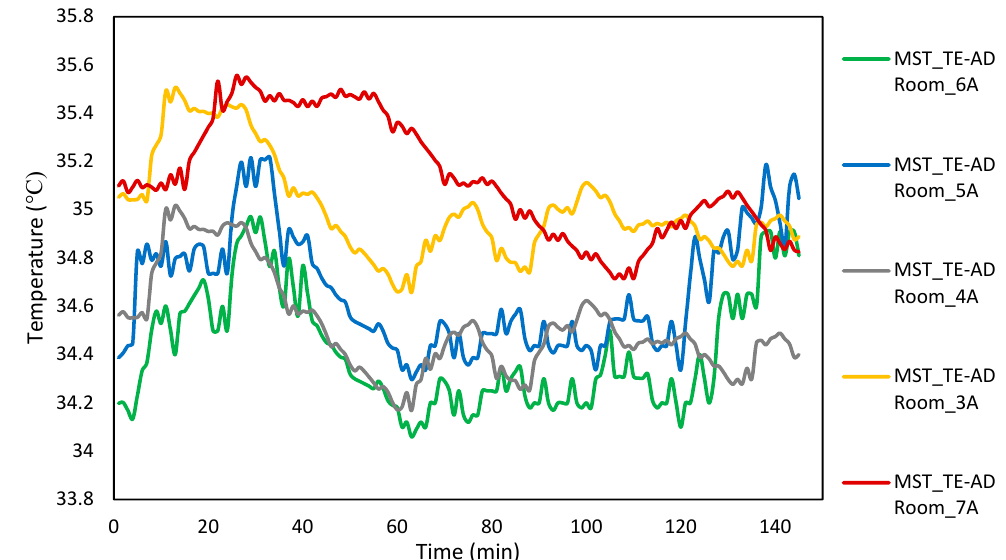
Figure 8. Variation in mean skin temperature at different operating powers.